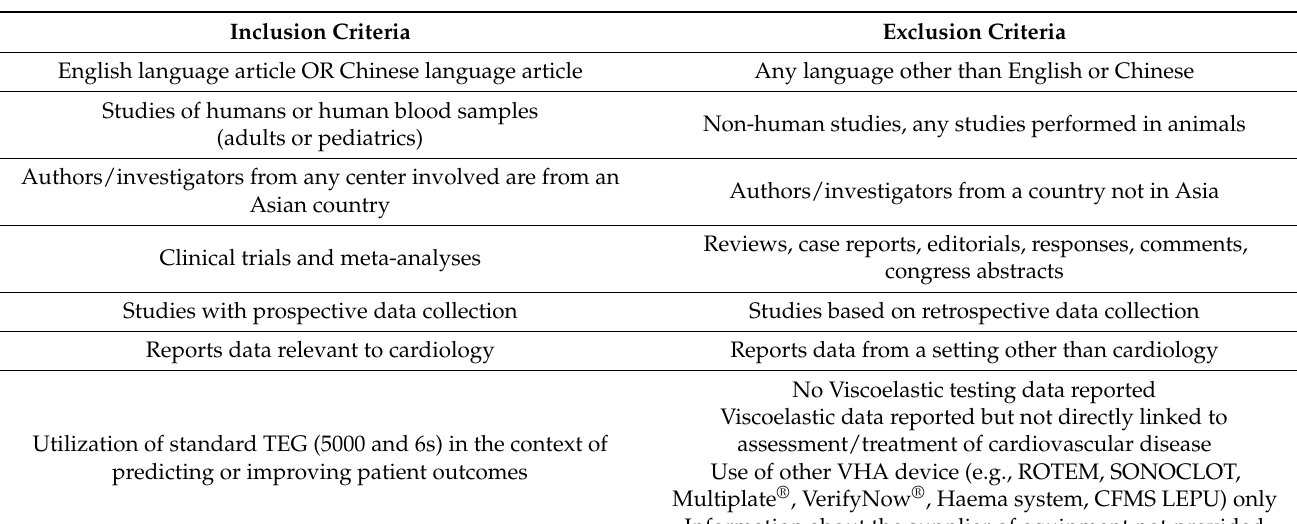
Figure 2. PRISMA diagram. TEG: thromboelastography. Table 1. Inclusion and exclusion